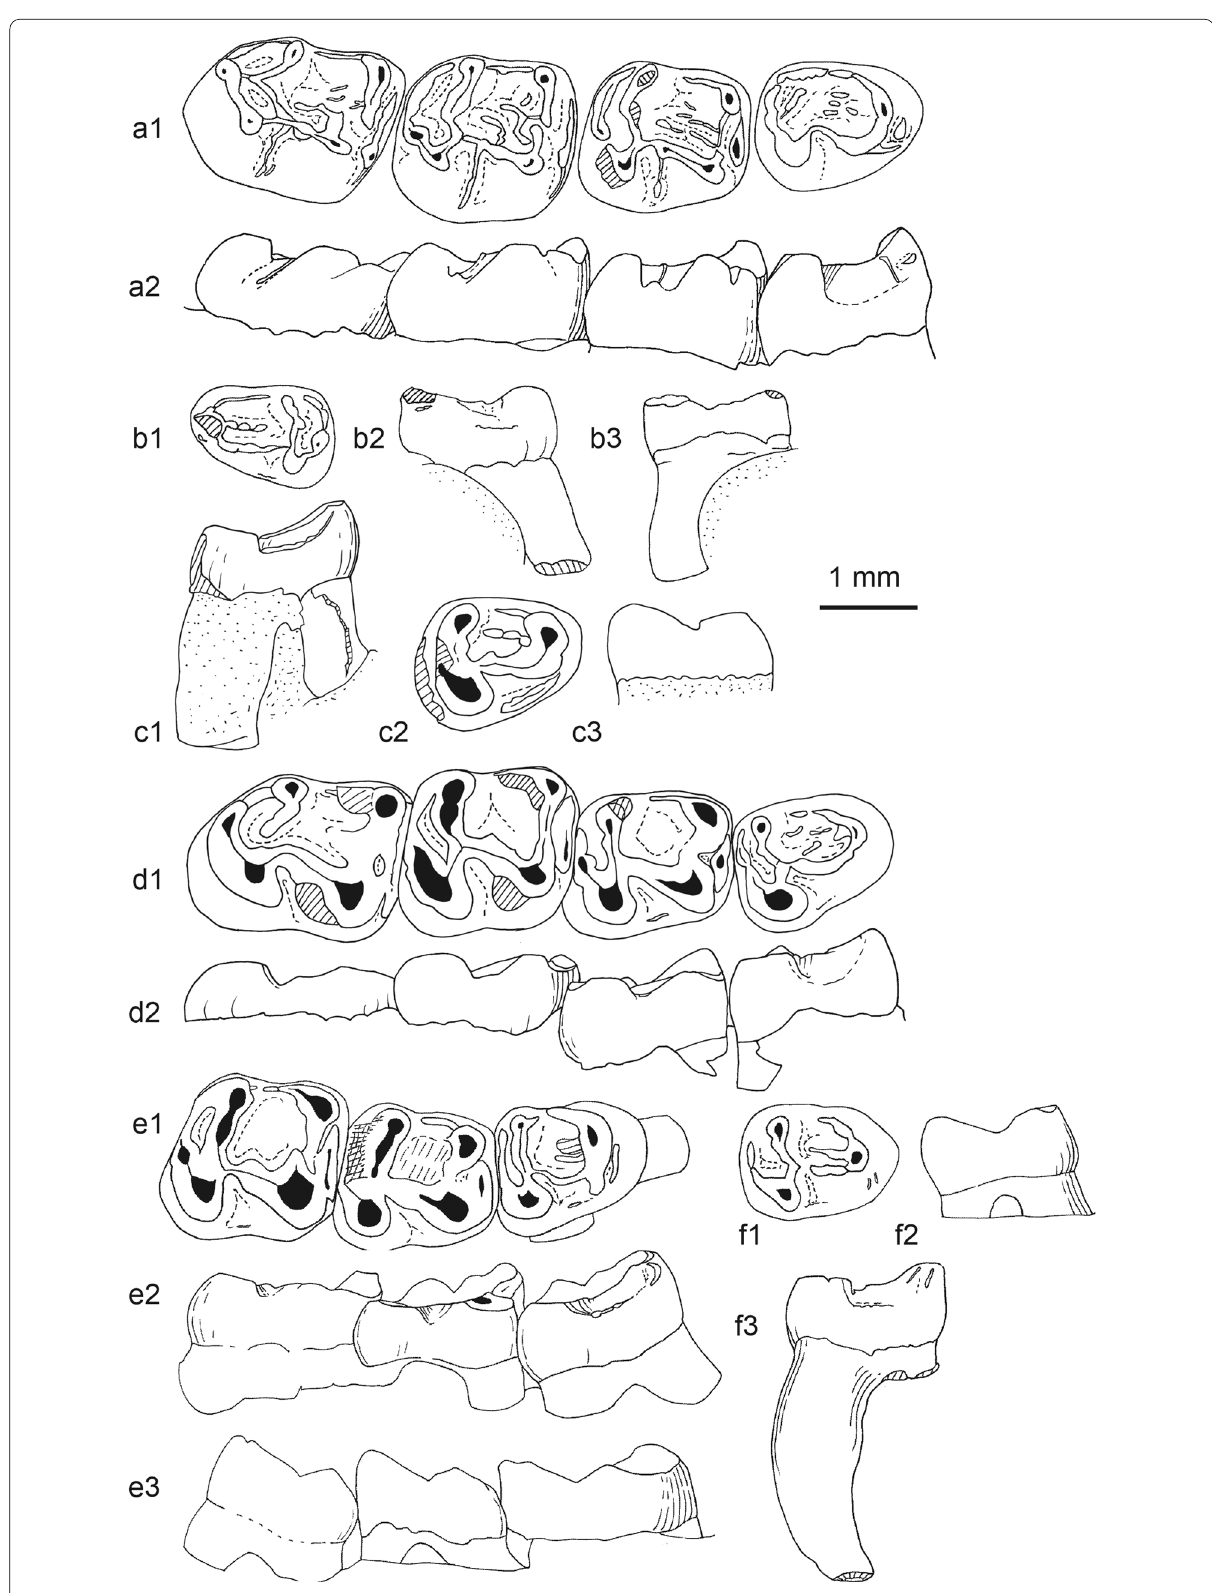
Fig. 18 (See legend on previous